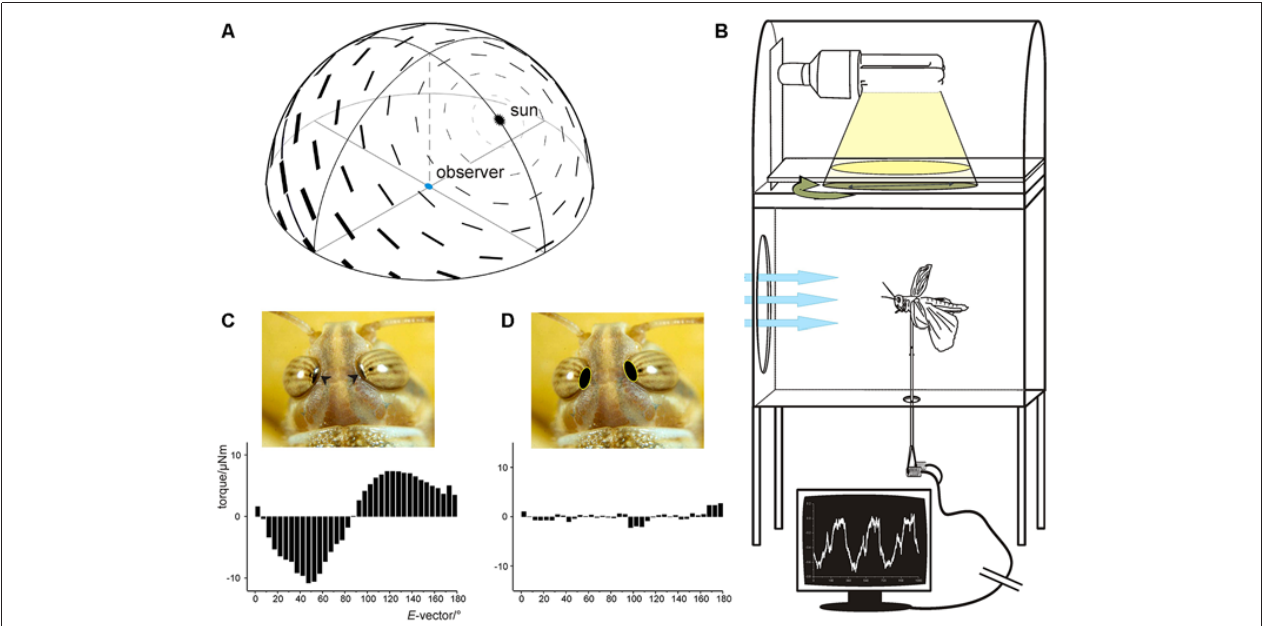
FIGURE 3 | (A) The celestial polarization pattern at a solar elevation of 50 ◦ . E -vectors of plane polarized light are arranged tangentially to concentric circles around the sun. The degree of polarization (bar thickness) is maximal at 90 ◦ from the sun. (B,D) Polarotaxis of the desert locust. (B) Experimental setup. The animal is mounted on a vertical rod attached to a yaw-torque meter. Tethered flight is initiated by laminar frontal wind (blue arrows). Yaw torque is measured while the animal is stimulated with white light from above passing through a rotating polarizer. (C) Averaged data of four 360 ◦ rotations of the polarizer reveals periodic changes in yaw torque corresponding with the periodicity of the polarizer. (D) When the dorsal rim areas of both eyes (arrowheads in C ) are covered with black paint, yaw torque becomes irregular and no longer corresponds to the position of the polarizer. (A) from Pfeiffer and Homberg (2014) with kind permission; (B) from Backasch (2009) with kind permission; (C,D) from Homberg